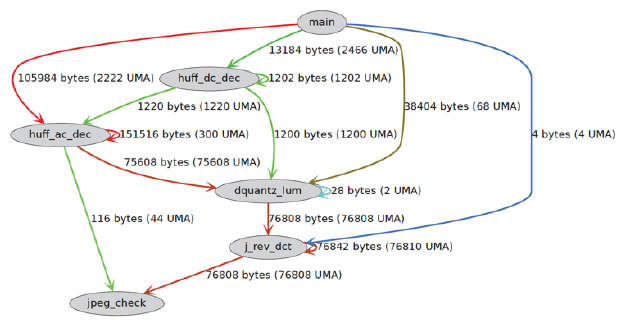
Figure 4. Data communication graph of the jpeg image converter